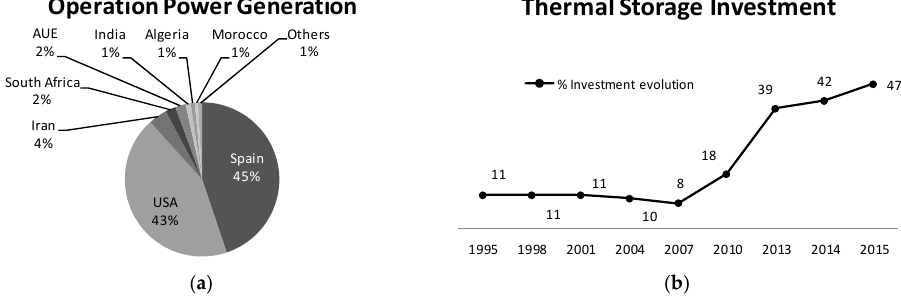
Figure 1. Currently operated parabolic trough (PT) power plants in the world (June 2016): ( a ) operating power generation by country; ( b ) double-tank molten salt thermal energy storage (TES) investment evolution in PT power plants [6].